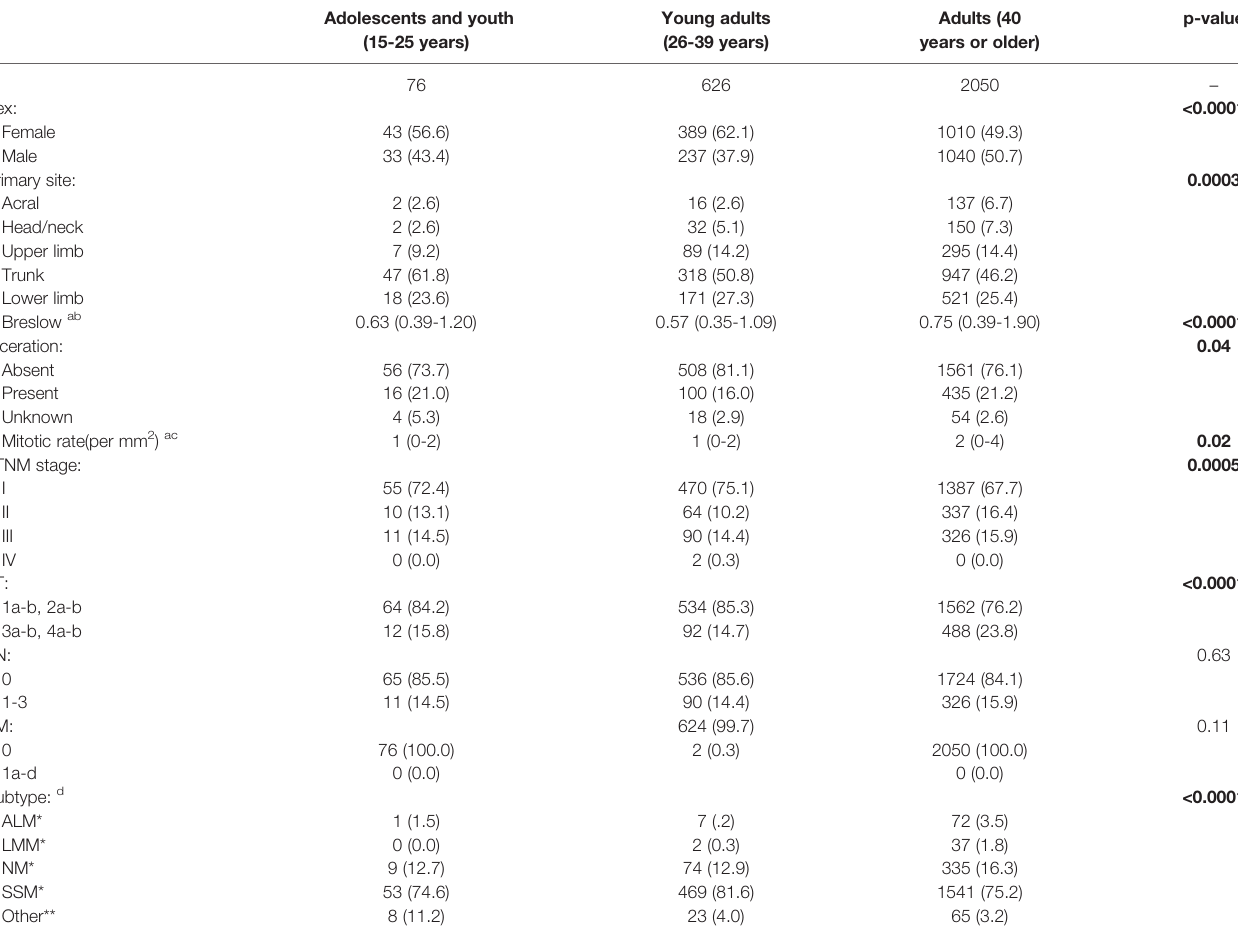
TABLE 1 | Patient and tumor characteristics in 2,752 patients aged ≥ 15 years and living in the Veneto Region who were diagnosed and/or treated for Melanoma of the skin between 1998-2014 at the Veneto Institute of Oncology and at the University Hospital of Padua (Italy): comparison between age classes (15-25 years, 26-39 years, 40 years or